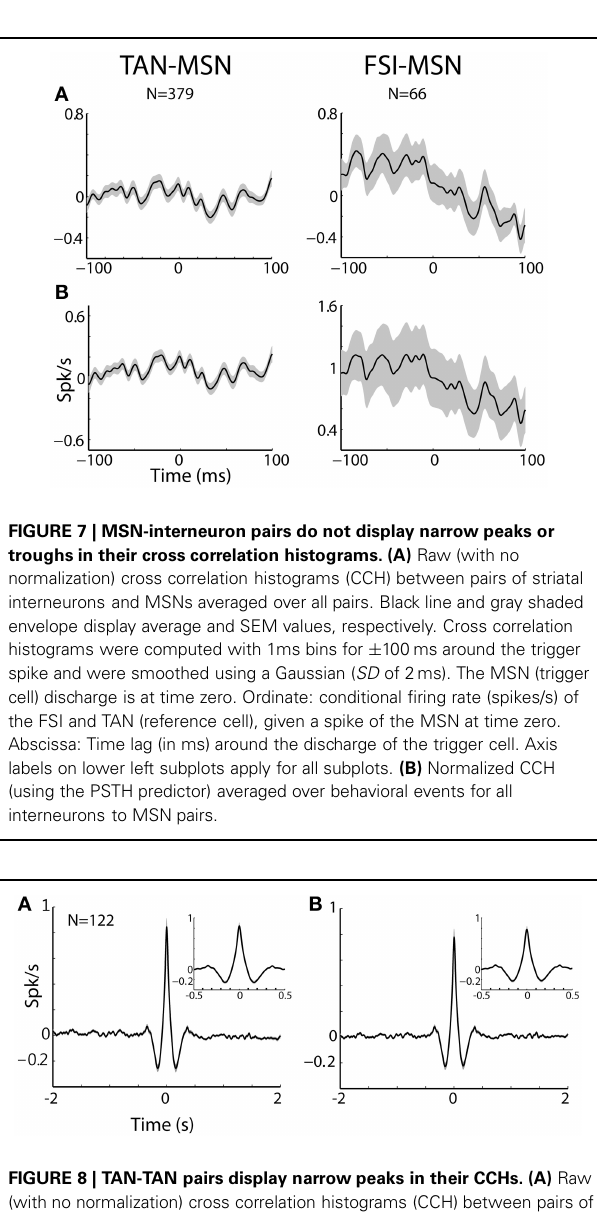
FIGURE 8 | TAN-TAN pairs display narrow peaks in their CCHs. (A) Raw (with no normalization) cross correlation histograms (CCH) between pairs of striatal TANs averaged over all simultaneously recorded pairs. Black line and gray shaded envelope display average and SEM values, respectively. Cross correlation histograms were computed with 1ms bins for ± 2000ms around the trigger spike and were smoothed using a Gaussian ( SD of 10ms). Ordinate: conditional firing rate of the reference cell, given a spike of the trigger cell at time zero. Inset: CCH at shorter time scale ( ± 500ms around the trigger spike). (B) Normalized CCH (using the PSTH predictor) averaged over behavioral events for all TAN to TAN